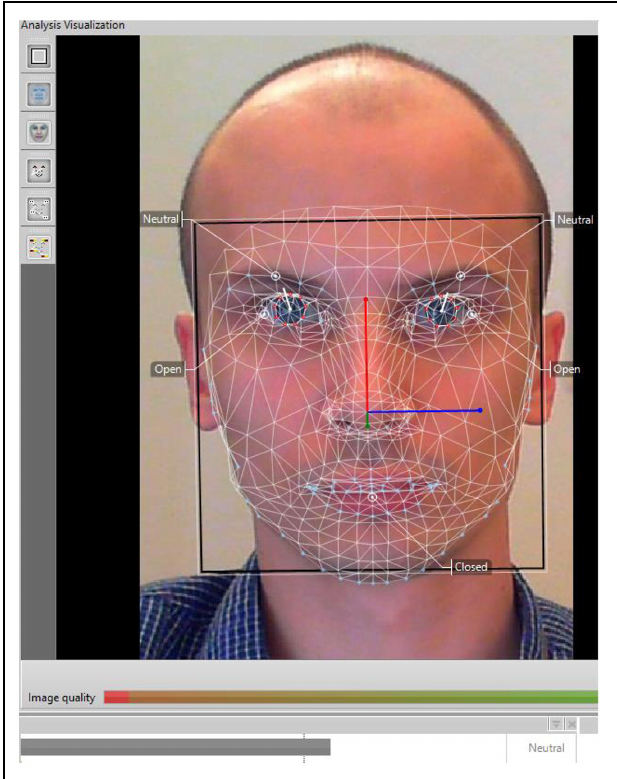
FIGURE 1 | FaceReader analysis of a neutral